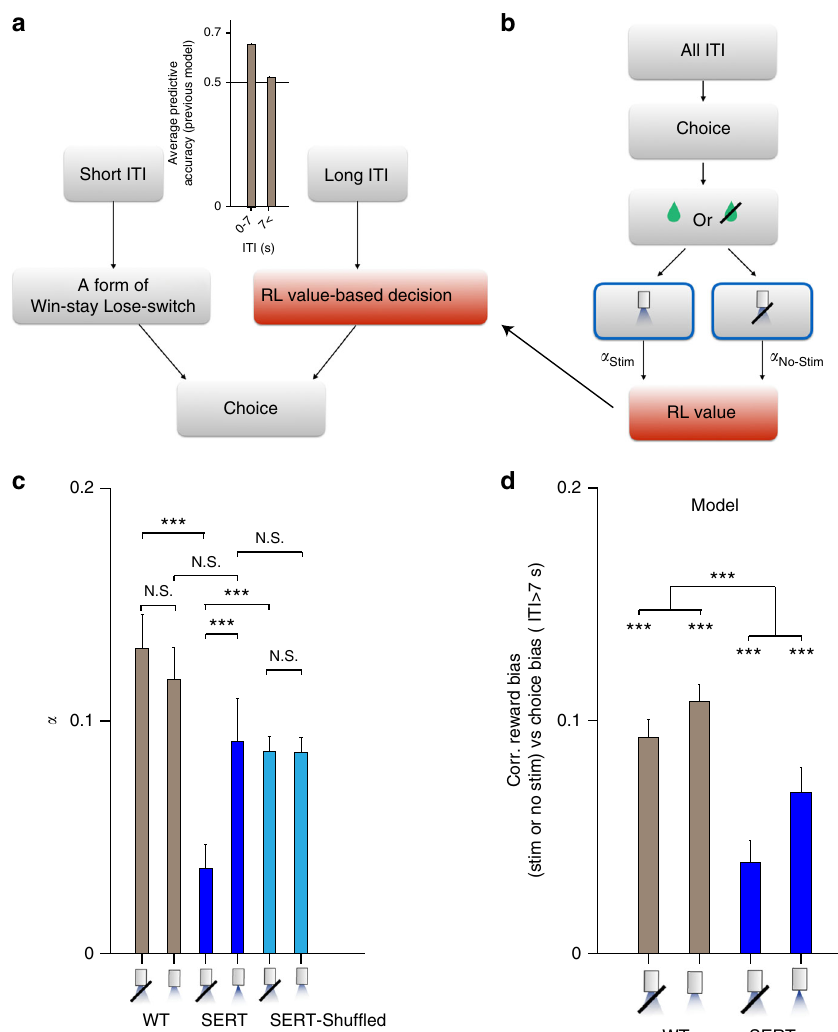
Fig. 3 DRN 5-HT stimulation increased the learning rate of SERT-Cre mice. a Schematics of the computational model. There are two separate decision- making systems: a fast system generating a form of “ win-stay, lose-switch, ” and a slow system following reinforcement learning (RL). After short ITIs ( T ITI < T Threshold ), choice is generated by the fast system following win-stay, lose-switch. After long ITIs ( T ITI > T Threshold ), choice is generated by the slow RL system. The ITI threshold T Threshold is a free parameter that is fi tted to data. b The RL system is assumed to learn the value of choice on all trials, including those with short ITIs for whose choices it was not responsible. The learning rate of the RL system is allowed to be modulated by photo-stimulation. When photo-stimulation is (respectively, is not) delivered, choice value is updated at the rate of α Stim ( α no-Stim ). The error bars indicate the mean ± SEM of sessions ( n = 32). c Photo-stimulation increased the learning rate of SERT-Cre mice. The estimated learning rates for the WT (left), SERT-Cre (center), and SERT-Cre mice with shuf fl ed stimulations (right) are shown. The difference between α Stim and α no-Stim in WT mice, between α Stim in WT mice and α Stim in SERT-Cre mice, between α Stim and α no-Stim in SERT-Cre mice with shuf fl ed stimulation conditions, and between α Stim in SERT-Cre mice and α Stim in SERT- Cre mice with shuf fl ed stimulation (right) conditions were not signi fi cant. The difference between α Stim and α no-Stim in SERT-Cre mice, and between α no-Stim in WT and α no-Stim in SERT-Cre mice were signi fi cant (permutation test, p < 0.001). The difference between α no − Stim in SERT-Cre mice and α no − Stim in SERT-Cre mice with shuf fl ed stimulations was also signi fi cant (permutation test, p < 0.01). d Generative test of the model. The analysis of Fig. 2b was applied to data generated by the model. The correlations were all signi fi cantly different from zero, while the difference between photo-stimulation and no photo-stimulation conditions between WT and SERT-Cre mice was also signi fi